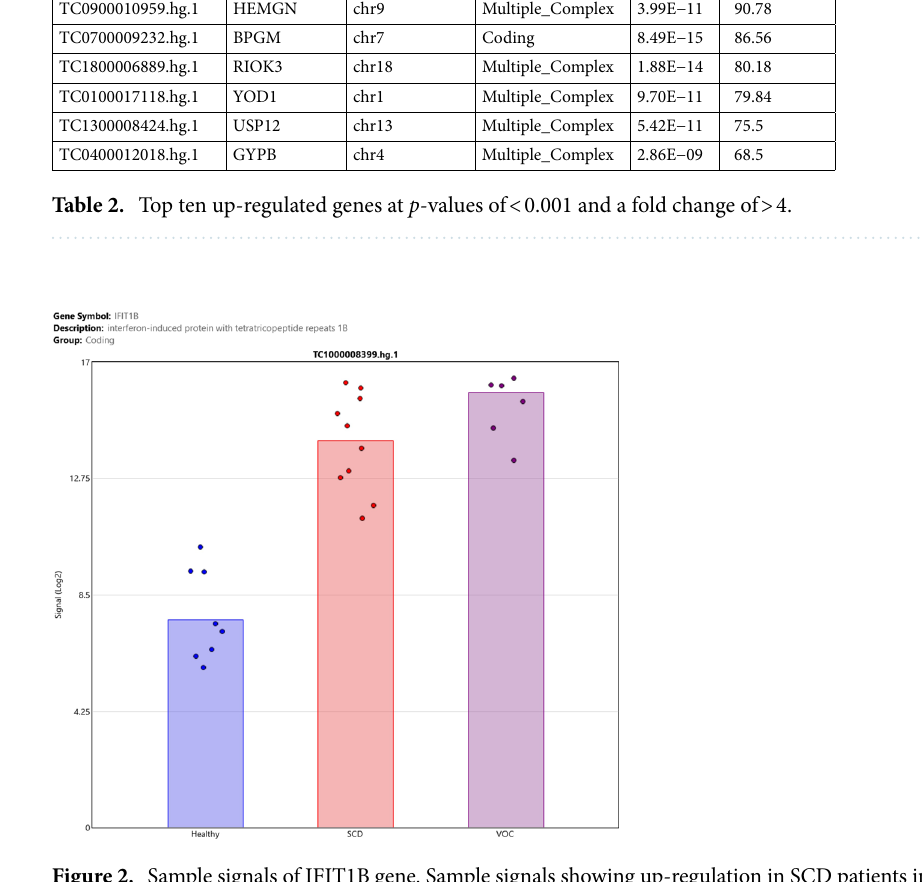
Figure 2. Sample signals of IFIT1B gene. Sample signals showing up-regulation in SCD patients in steady-state and VOC compared to healthy controls with a false discovery rate of 5.41 × 10 –8 and a fold change of 70.57 and 313.47,